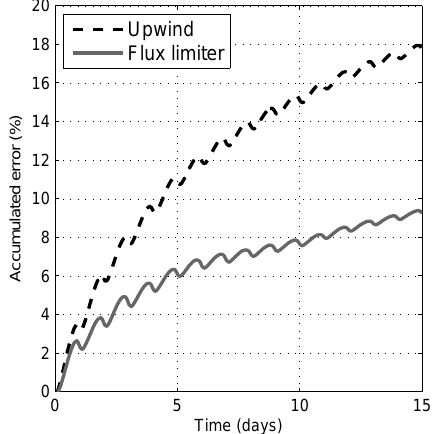
Fig.6: Accumulatedmassbalanceerrorsforthefluxlimiterandupwindschemesover15daysofsimulation. Fig. 6. Accumulated mass balance errors for the flux-limiter and upwind schemes over 15 days of